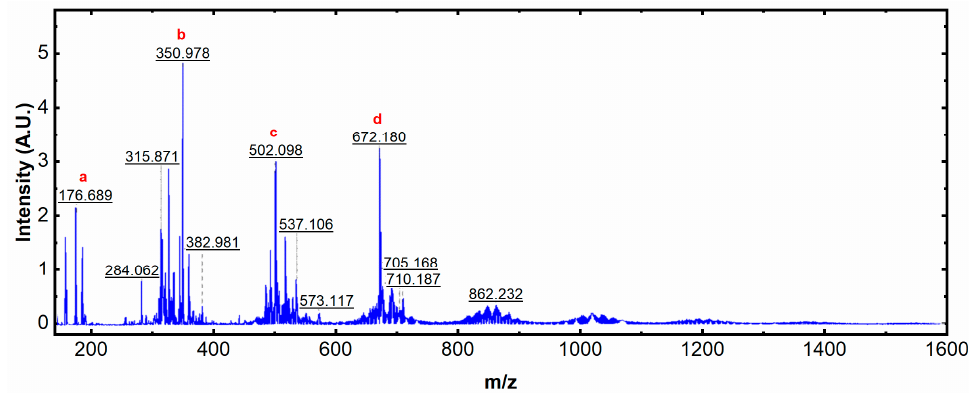
Figure 2. MALDI-TOF/TOF mass spectrum of the SE-derivative fluorophore (SEDF) obtained by heating 2 g L − 1 serotonin at 60 °C for 2 h in 10 mM TRIS at pH 9.00. The m / z values compatible with SE monomer ( a ), dimer ( b ), trimer ( c ), and tetramer ( d ) molecules are reported.